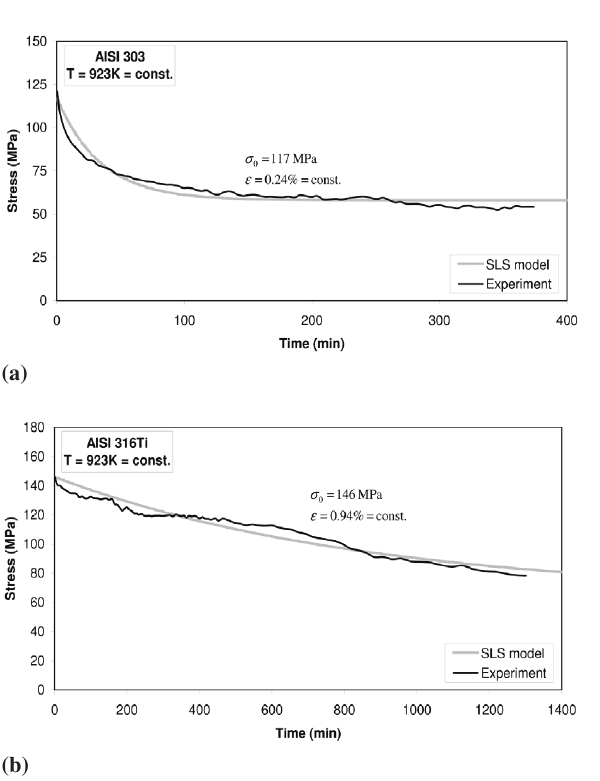
Table 5. Relaxation modeling data.